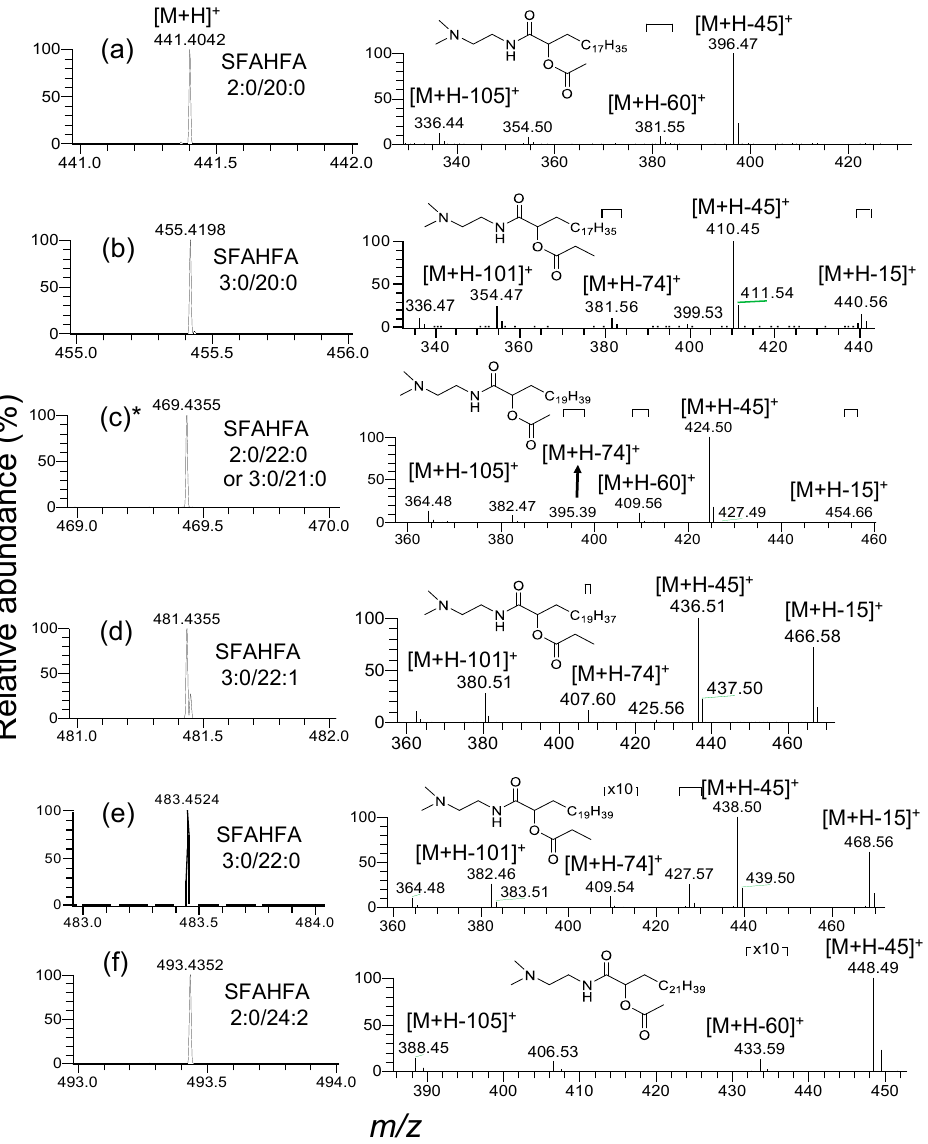
Figure 3. Mass spectra (MS 1 ) of DMED-labeled SFAHFAs and their acquired MS/MS spectra along with tentative chemical structures ( a–f ). (*represents the isomeric mixtures).